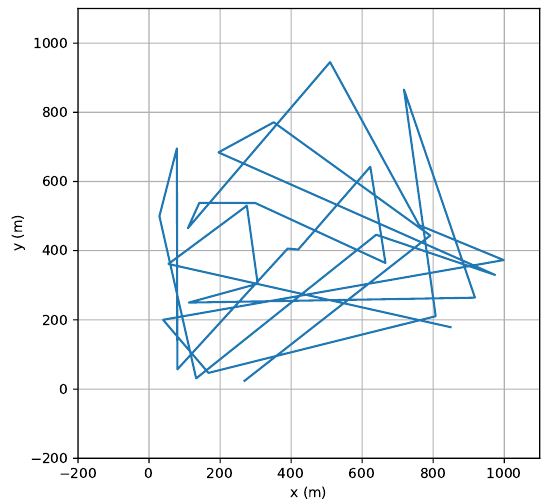
Figure 1. An example of a node’s movement using the random direction mobility model.